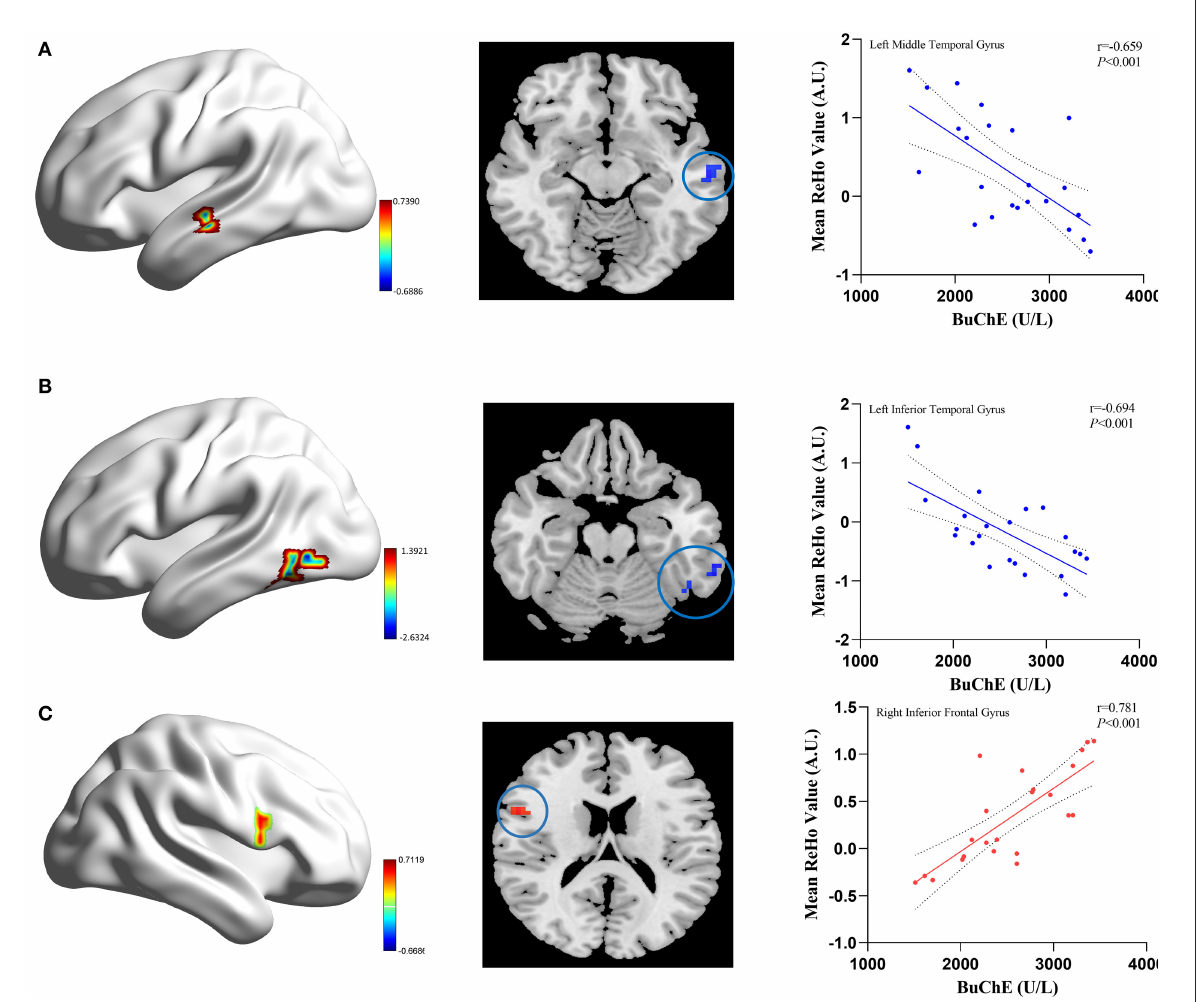
FIGURE3 The correlation between the mean ReHo values and BuChE activity in the MHE patients. The BuChE activity negatively correlates with ReHo values in the left middle temporal gyrus (A) , left inferior temporal gyrus (B) (blue color), and positively correlate with ReHo values in the right inferior frontal gyrus (C) (red color).